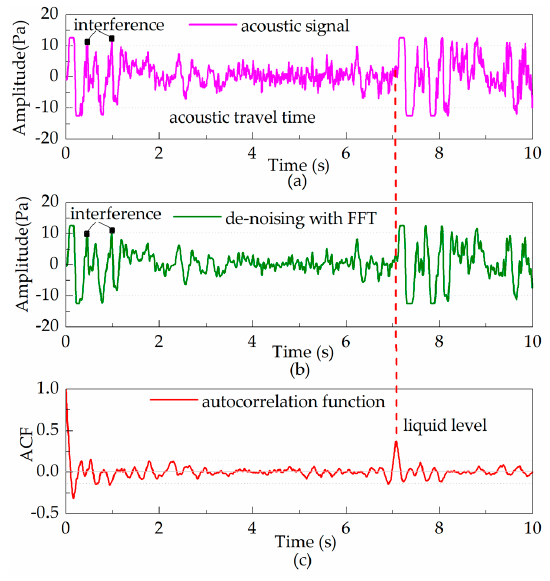
Figure 18. Waveform of test acoustic signal ( a ); acoustic signal with FFT-based denoising method ( b ); ACF of the acoustic signal ( c ).